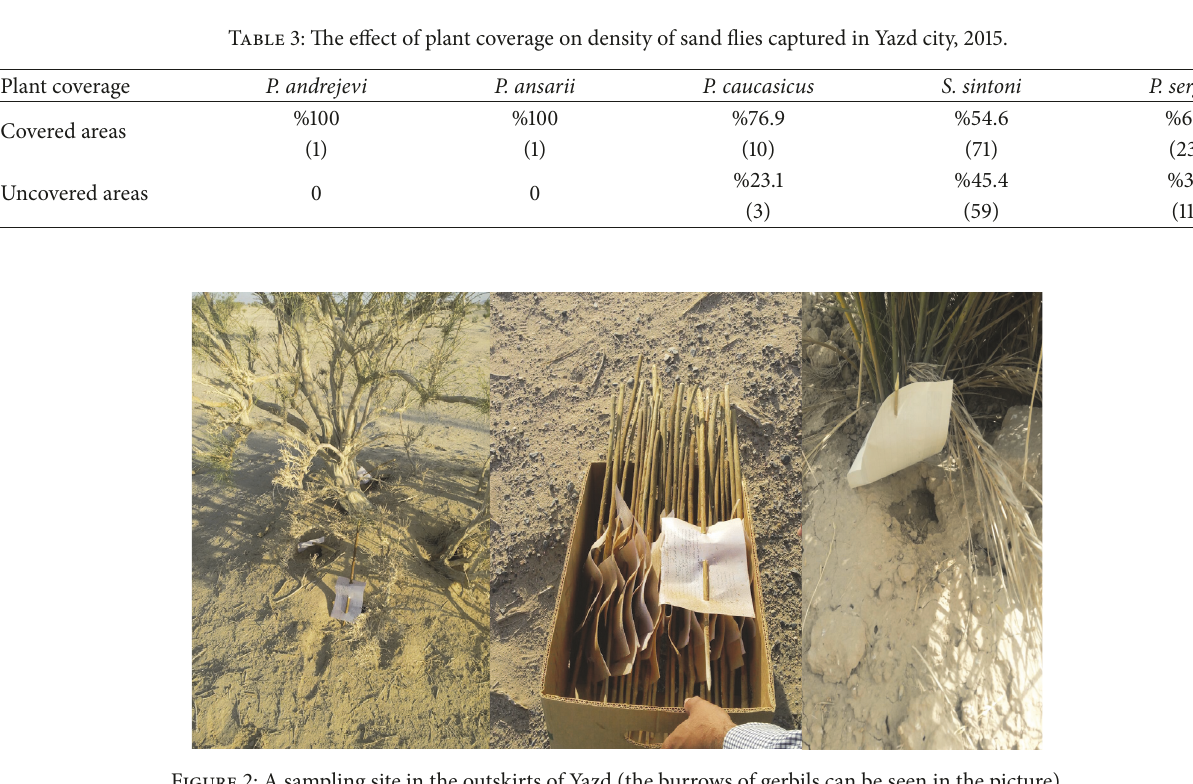
P. alexandri had the lowest frequency each with only one specimen (Table